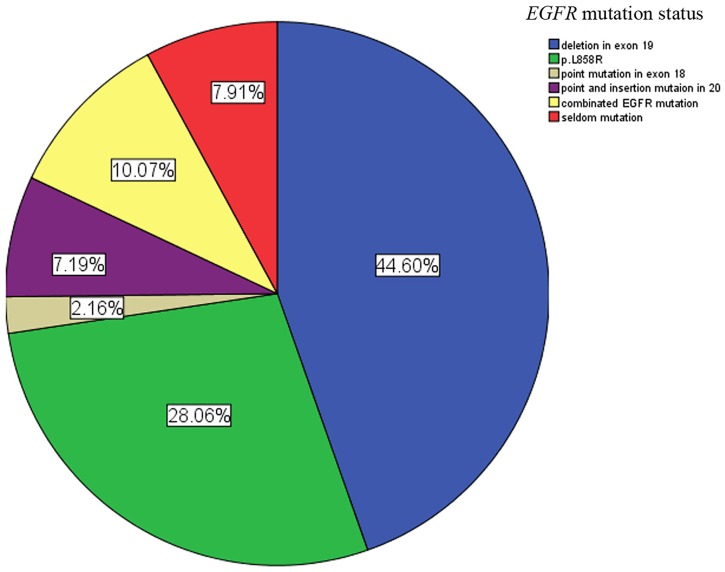
The percentage composition of the detected EGFR mutations.Note:- Combined EGFR mutation stands for mutation at least was found in two exons (18–21), for example point mutation in 18 and 20 exons.        - Seldom mutation means at least two combination of the way of EGFR mutation, such as deletion combined insertion in exon 19.        - There was one patients had both deletion in exon 19 and p.L858R.